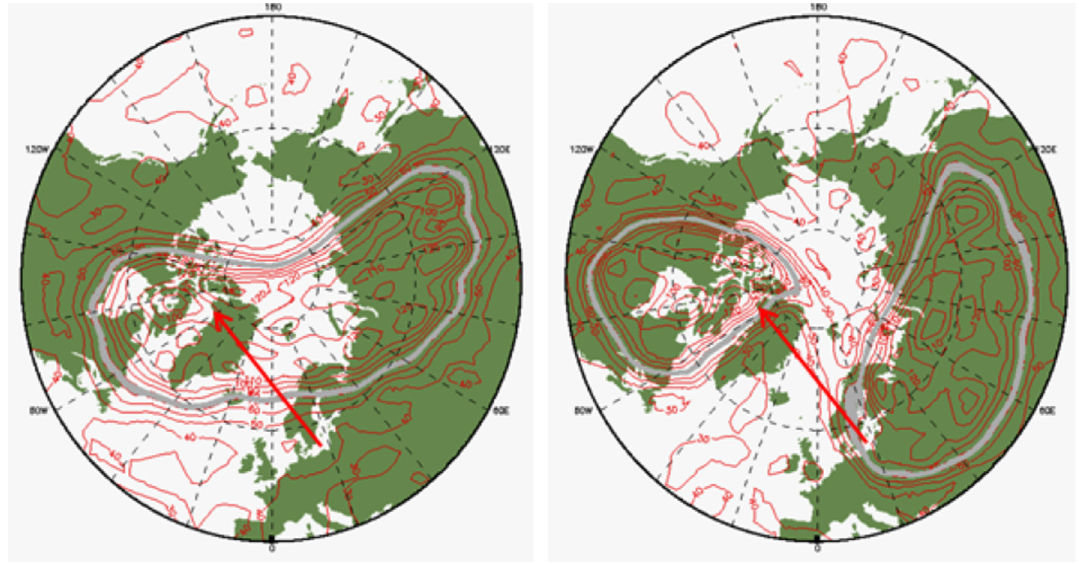
Figure 12. Potential vorticity (PV) contour maps at 550 K (22-23 km altitude) from ECMWF reanalyses showing the splitting of the Arctic polar vortex occurring (at this altitude) between January 23 (map on the left) and 27 (map on the right). The red arrows point to the north- western coast of Greenland where Thule is